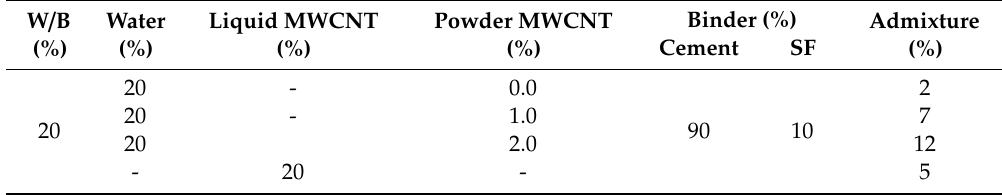
Table 4. Mixture proportions (mass fraction).